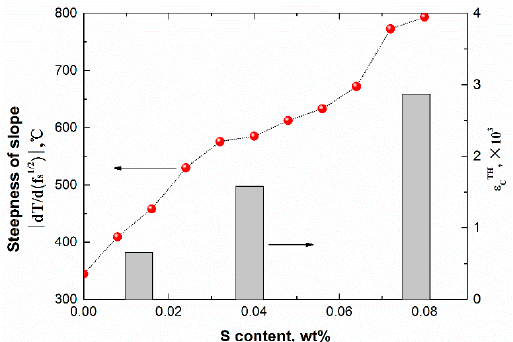
Figure 10. Comparison of the crack susceptibility of peritectic steels with different S contents, as well as the strain.